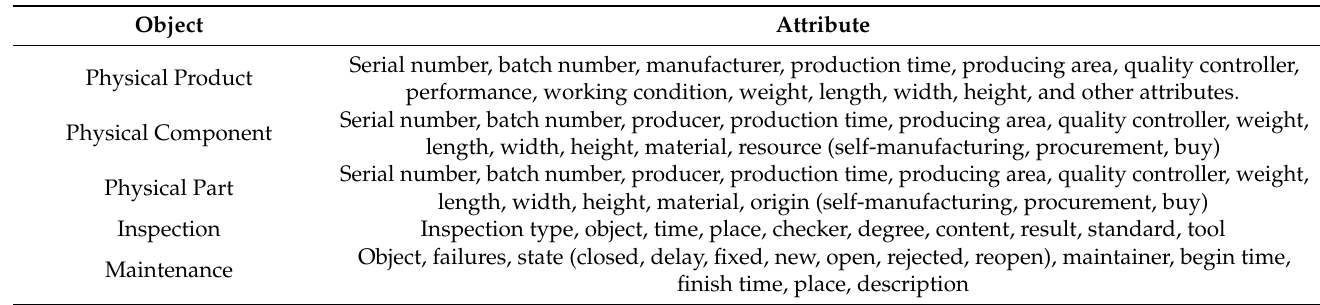
Table 3. Attributes of a physical